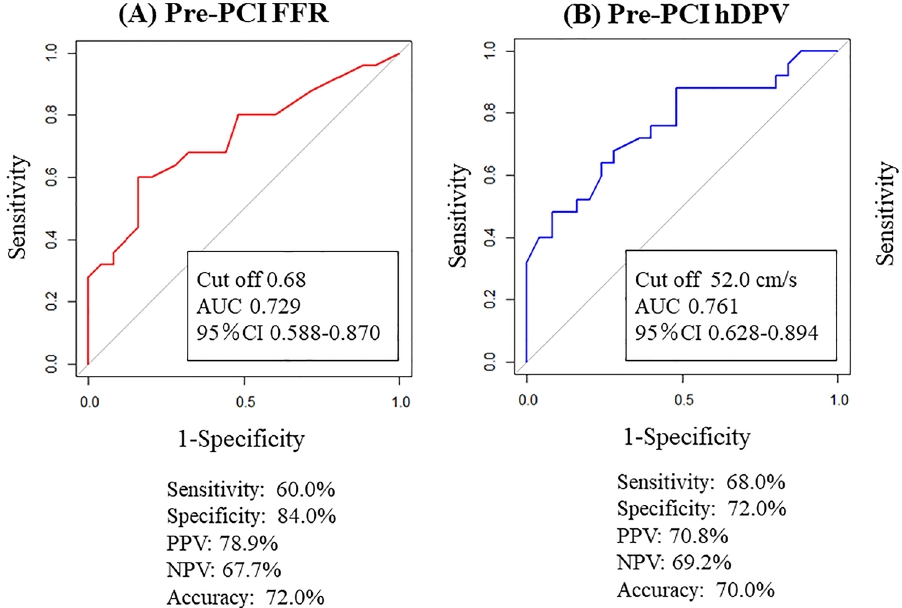
Figure 3. ROC analyses to determine the optimal cut-off values to predict a significant coronary flow increase. ( A ) ROC analysis of pre-PCI FFR to predict a significant coronary flow increase. ( B ) ROC analysis of pre-PCI